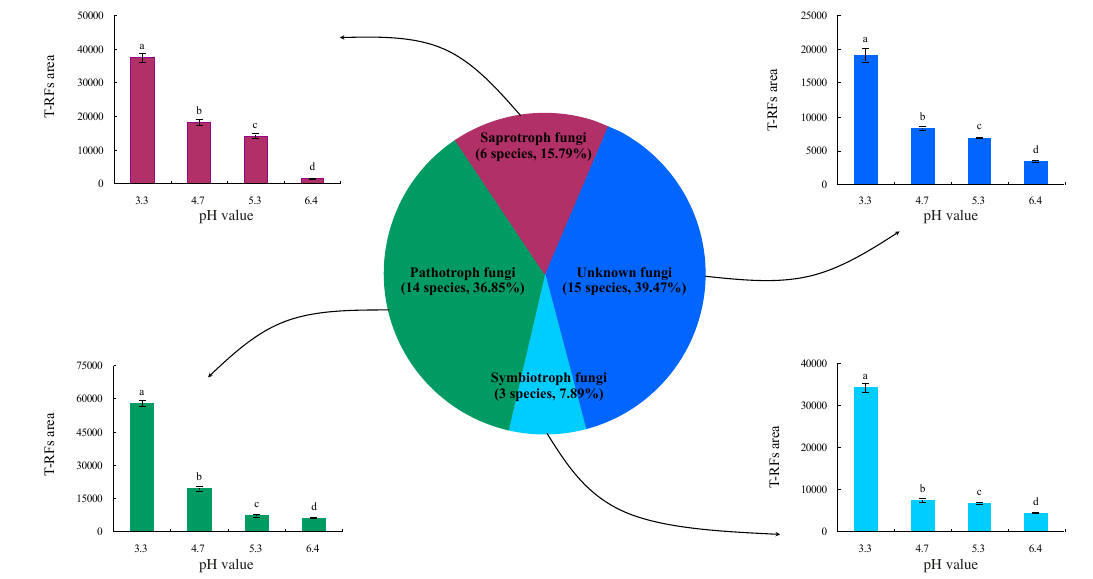
Fig. 3: The proportions of fungi in different trophic mode and their T-RFs fragments area distribution in soil at different pH